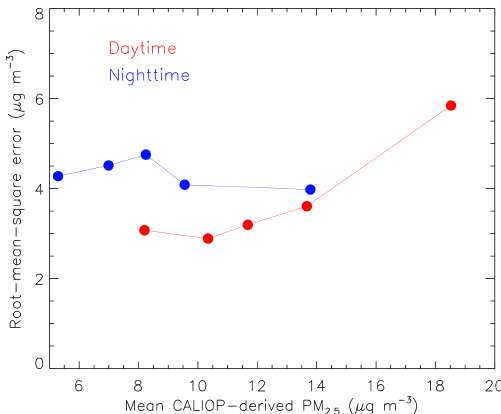
Figure 5. Root-mean-square errors of CALIOP-derived PM 2 . 5 against EPA PM 2 . 5 as a function of CALIOP-derived PM 2 . 5 , us- ing both daytime (in red) and nighttime (in blue) CALIOP obser- vations. The five bins are equally sampled based upon a cumulative histogram analysis, and each point from left to right represents the RMSE and mean PM 2 . 5 concentration derived from CALIOP for 0%–20%, 20%–40%, 40%–60%, 60%–80%, and 80%–100% cumulative